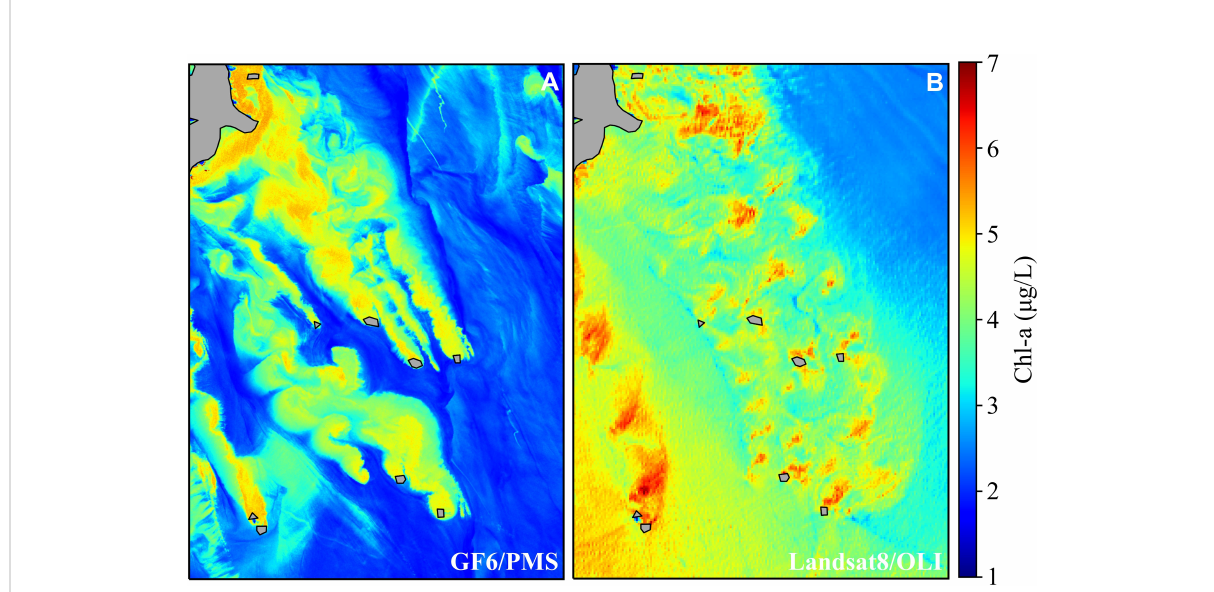
FIGURE 10 Comparison of the detailed distribution of Chl- a concentrations in the waters around islands on GF-6/PMS and Landsat8/OLI images. (A) Distribution of Chl- a concentration in GF-6/PMS image; (B) distribution of Chl- a concentration in landsat-8/OLI